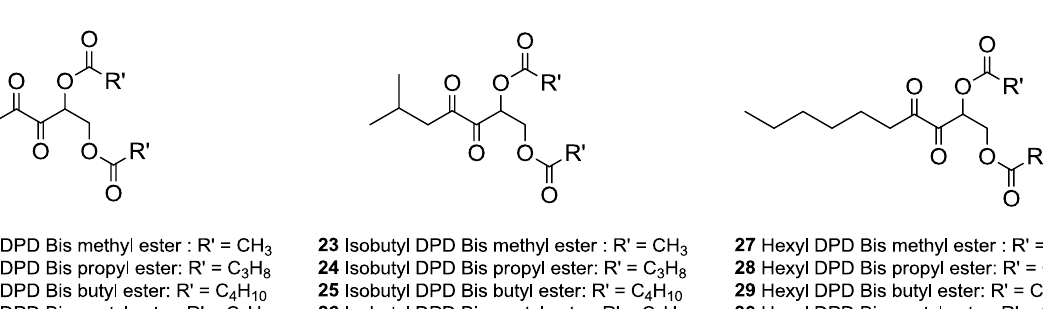
Figure 2. Compounds evaluated as bis -ester protected AI-2